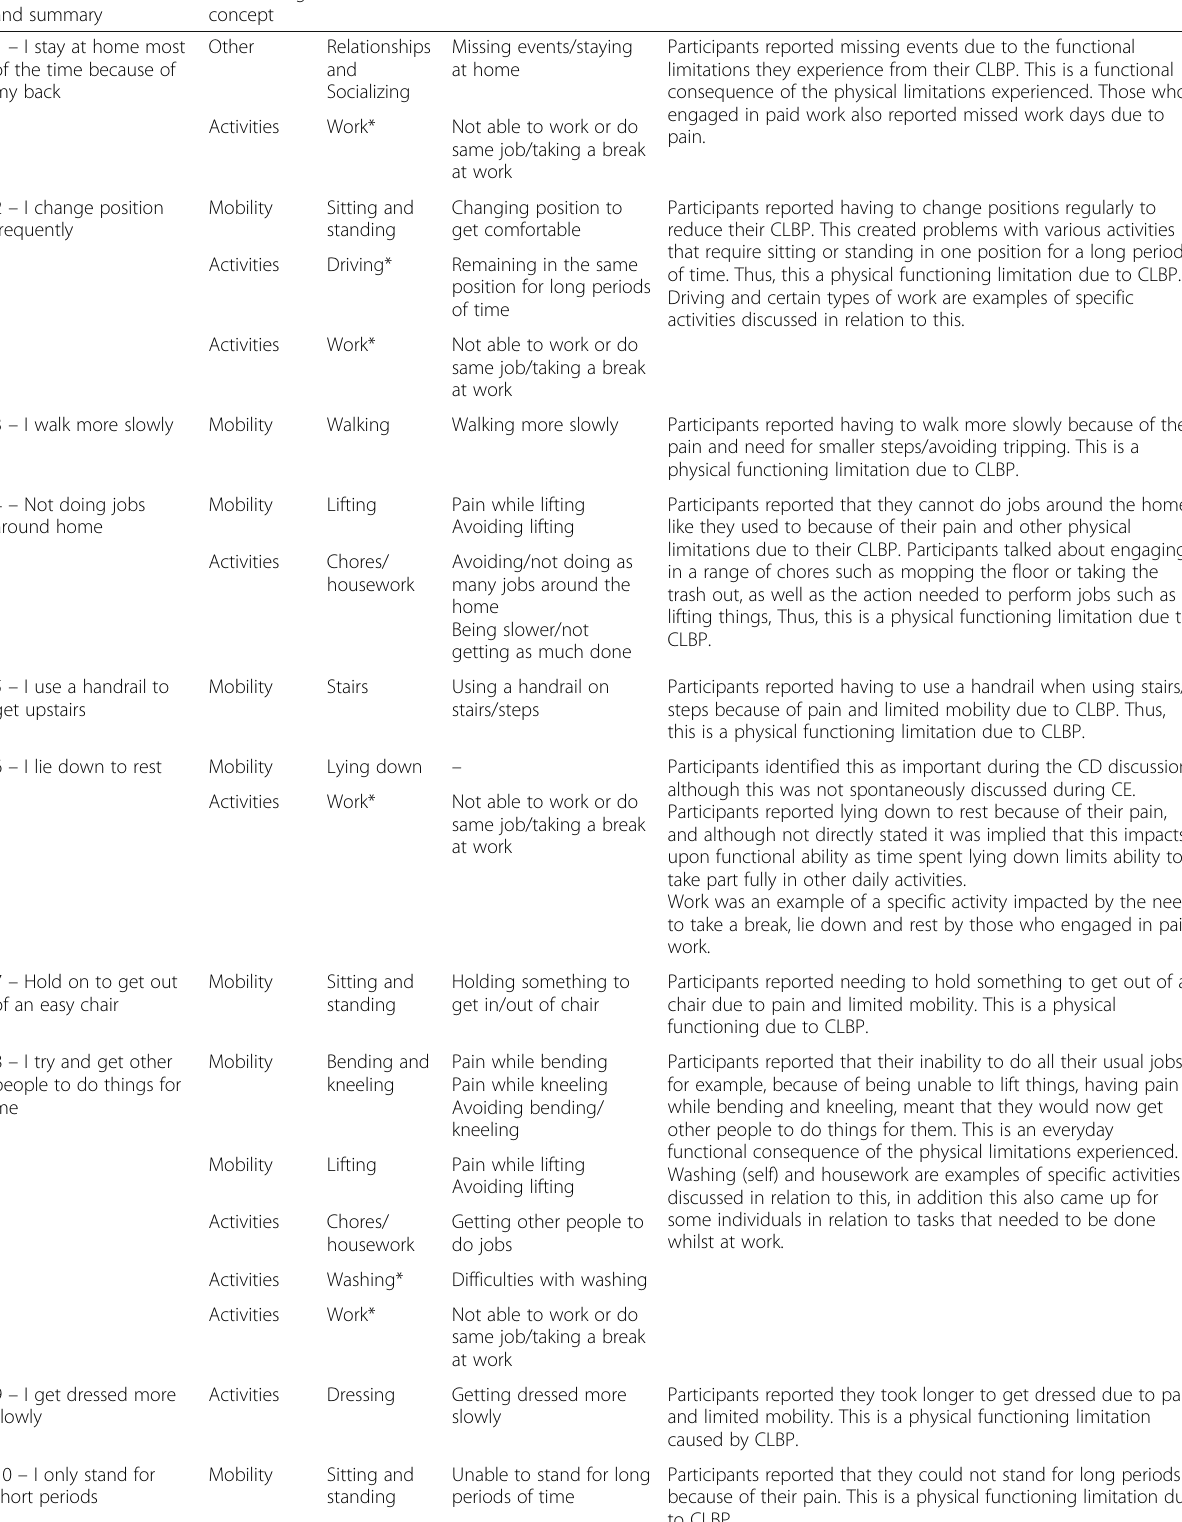
Table 3 Mapping the themes identified in coding to the RMDQ items RMDQ - item number and